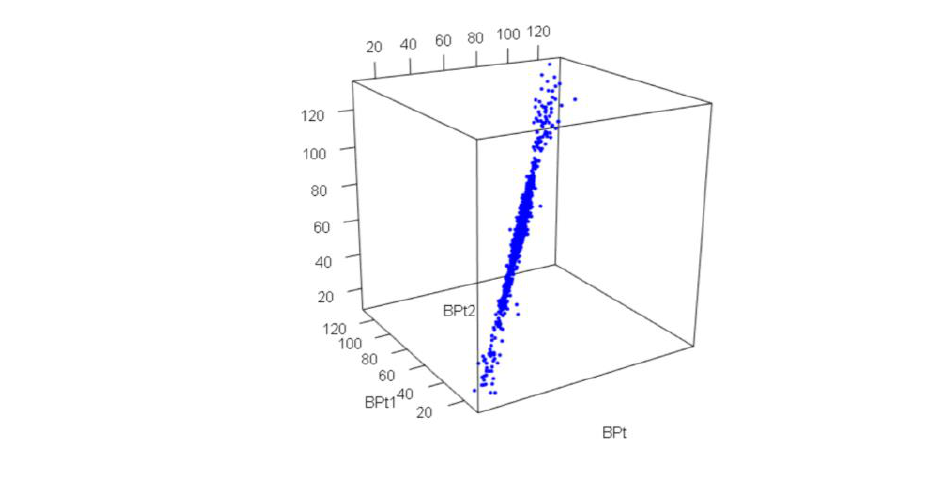
Figure 2: Multiple equilibria in Crude oil Brent Europe 3-d embedding space; Source: